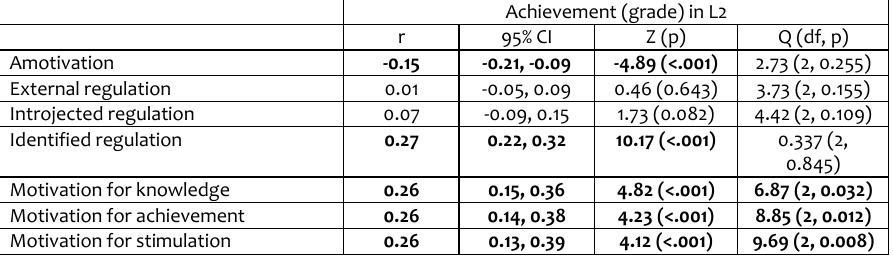
Table 5. Basic parameters of meta-analysis between L2 learning motivation and L2 success